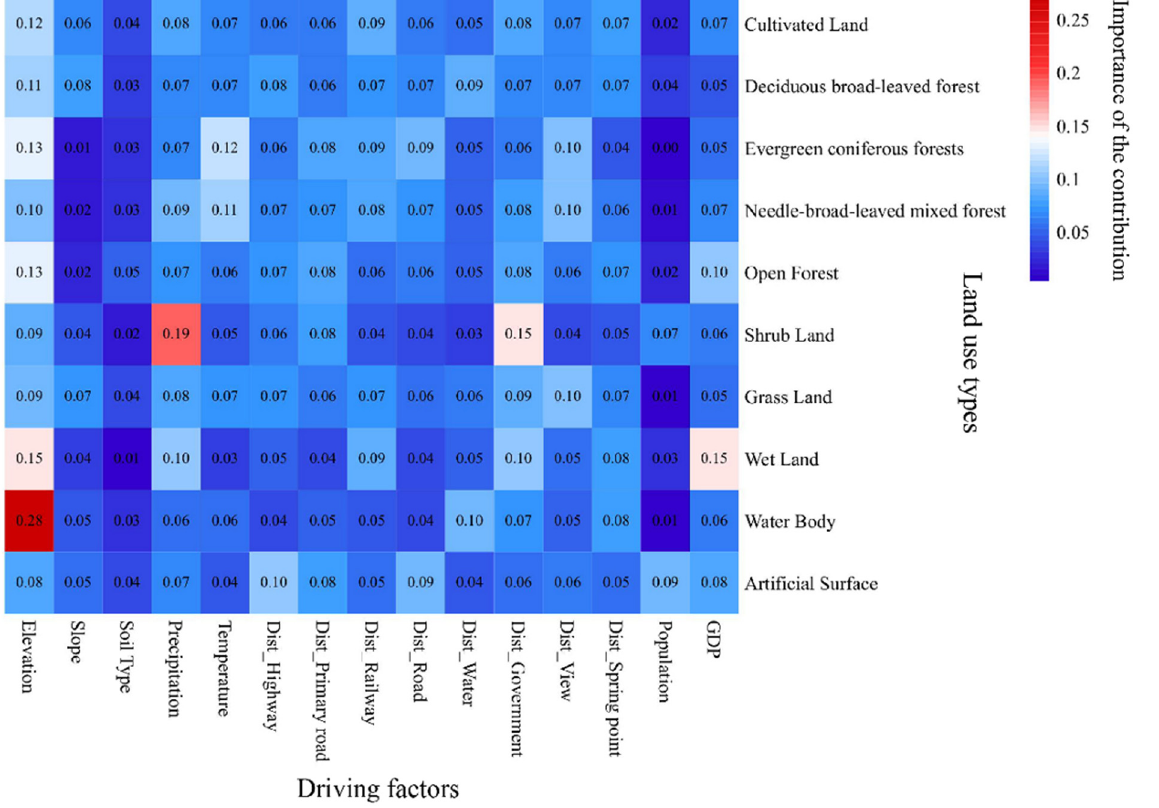
Figure 5. Heat map of the importance of the contribution of each driving factor to the growth of specified land use types.